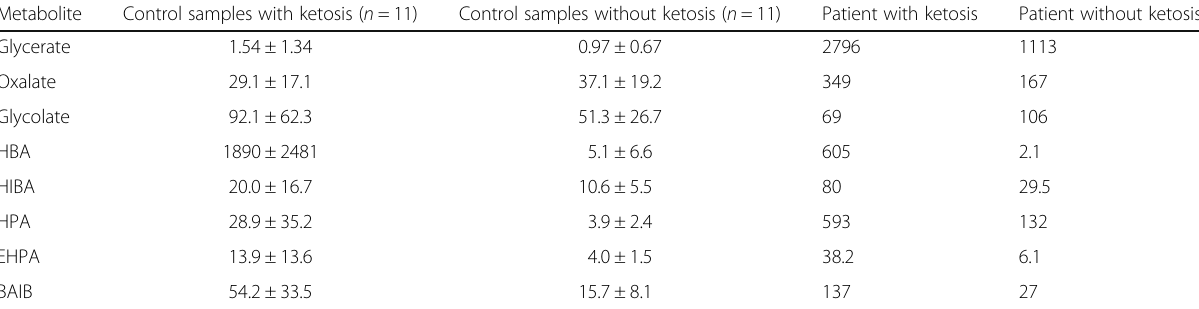
Table 1 The comparison of urine excretion of metabolites related to primary hyperoxaluria and ketosis in patient and control urine samples with/without ketosis. Values are expressed in mmol/mol creatinine as means ± standard deviation (BAIB - β -aminoisobutyric acid,